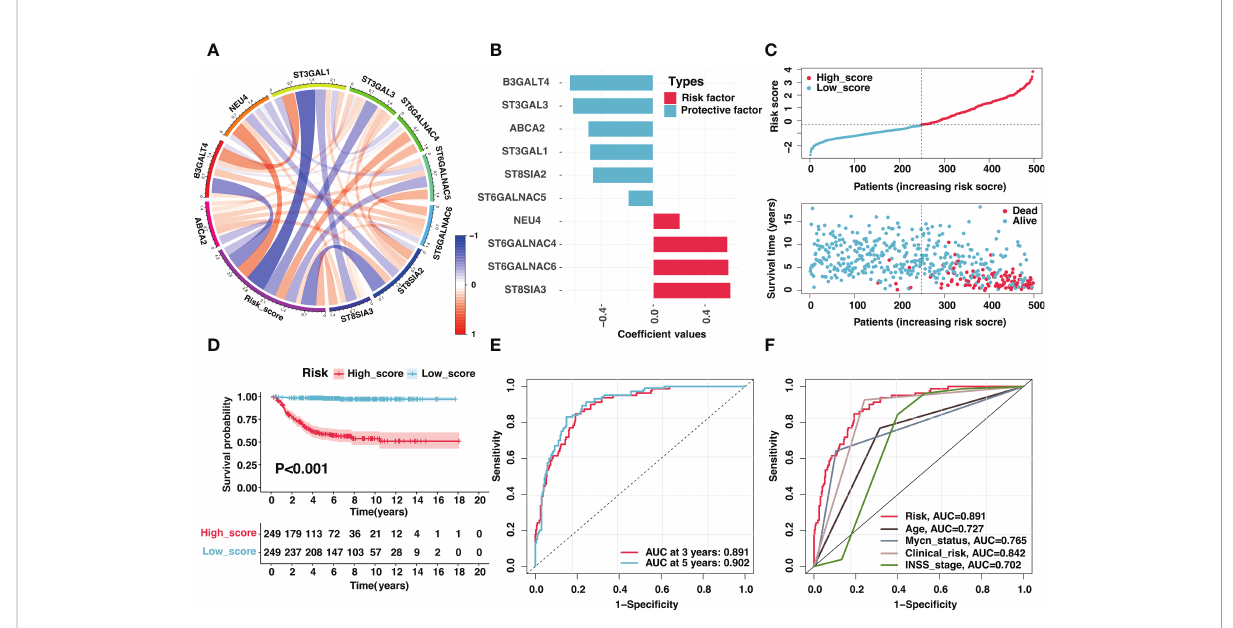
FIGURE 4 Validation of the ganglioside-related risk signature in the GSE49710 dataset. (A) The correlation coef fi cient between risk score and signature genes. (B) Coef fi cient values of ten signature genes. (C) The distribution of the risk score (top) and survival time (bottom) in the GSE49710 cohort. (D) Kaplan – Meier curves of overall survival (OS) in GSE49710 cohort between different risk groups. (E) The receiver operating characteristic (ROC) curves of the risk signature for 3-year and 5-year OS prediction in the GSE49710 cohort. (F) The ROC curves of clinical prognostic factors for 3-year OS prediction in the GSE49710